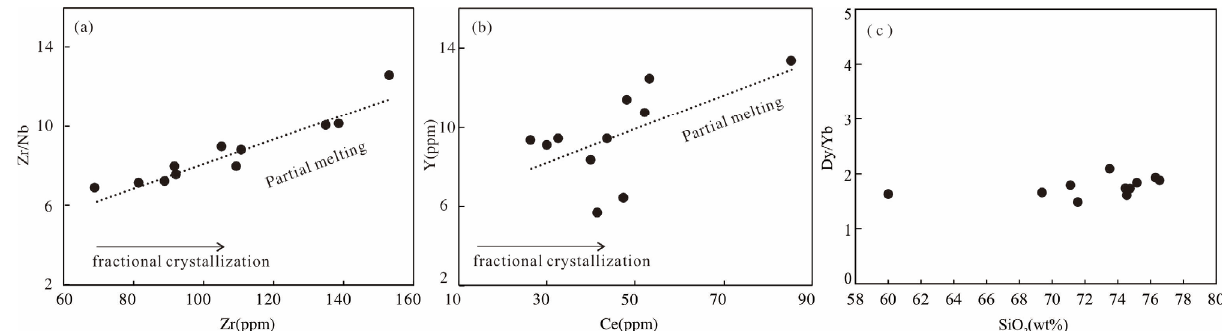
Figure 9. ( a ) Zr/Nb vs. Zr diagram; ( b ) Y vs. Ce diagram; ( c ) Dy/Yb vs. SiO 2 diagram.